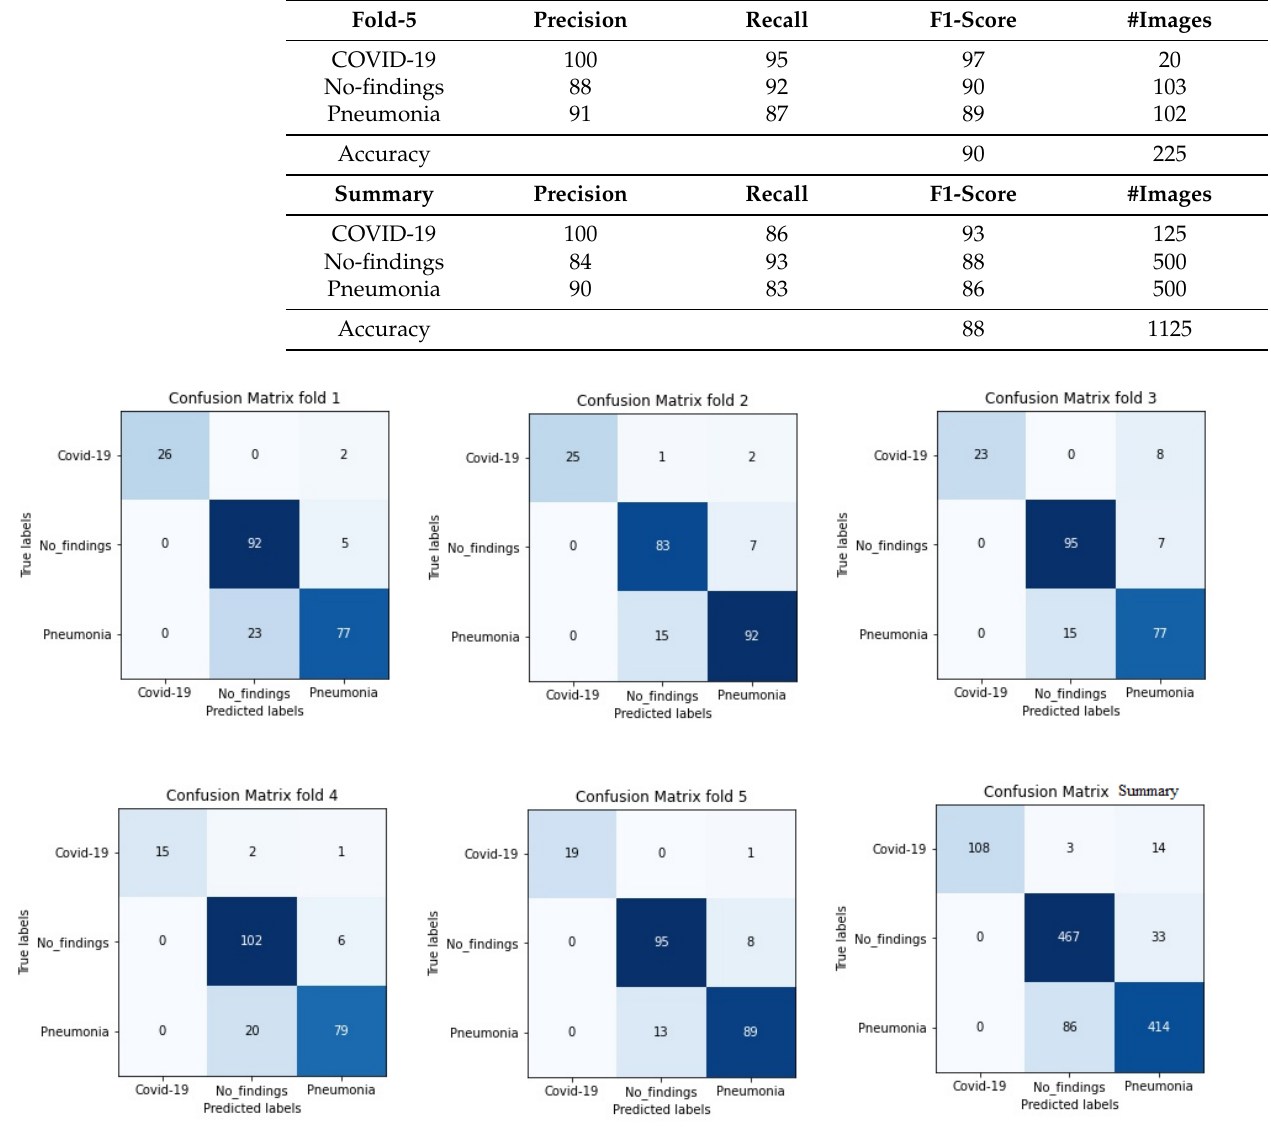
Figure 6. Confusion matrix of 5 folds for Densenet-161 trained with X-ray images and with ADAM optimizer (testing